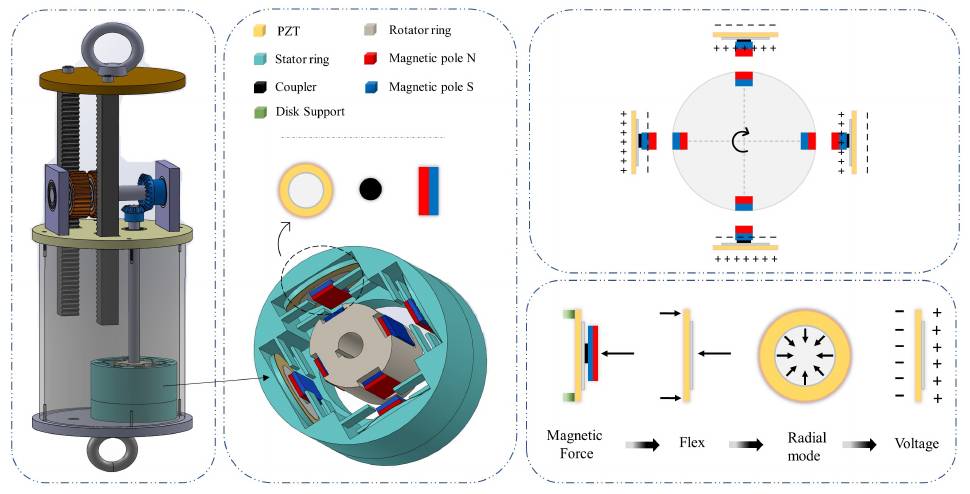
Figure 4. Schematic of the magnetically coupled piezoelectric vibration energy harvester (MPVEH).